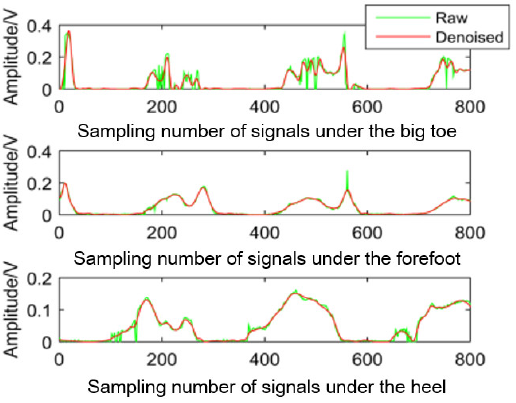
Figure 10. Characteristic values of plantar pressure signals.